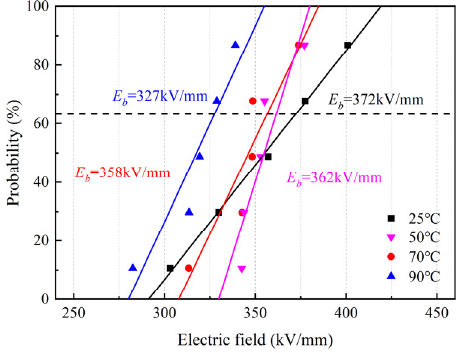
Figure 9. Schematic diagram of the effect of pre-applied space charge on breakdown strength. ( a ) heterocharges; ( b ) homocharges.